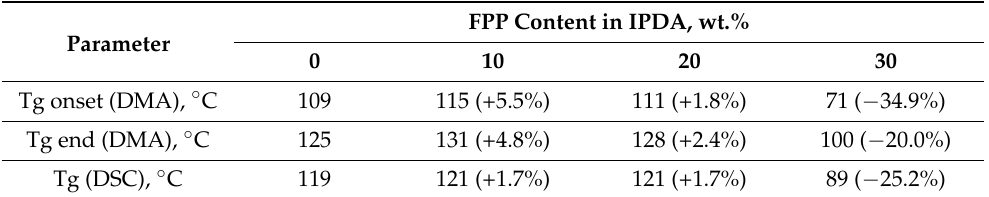
Table 4. Dependence of the glass transition temperature of the cured compositions on the modifier content (the relative change with respect to the modifier-free samples is shown in brackets).